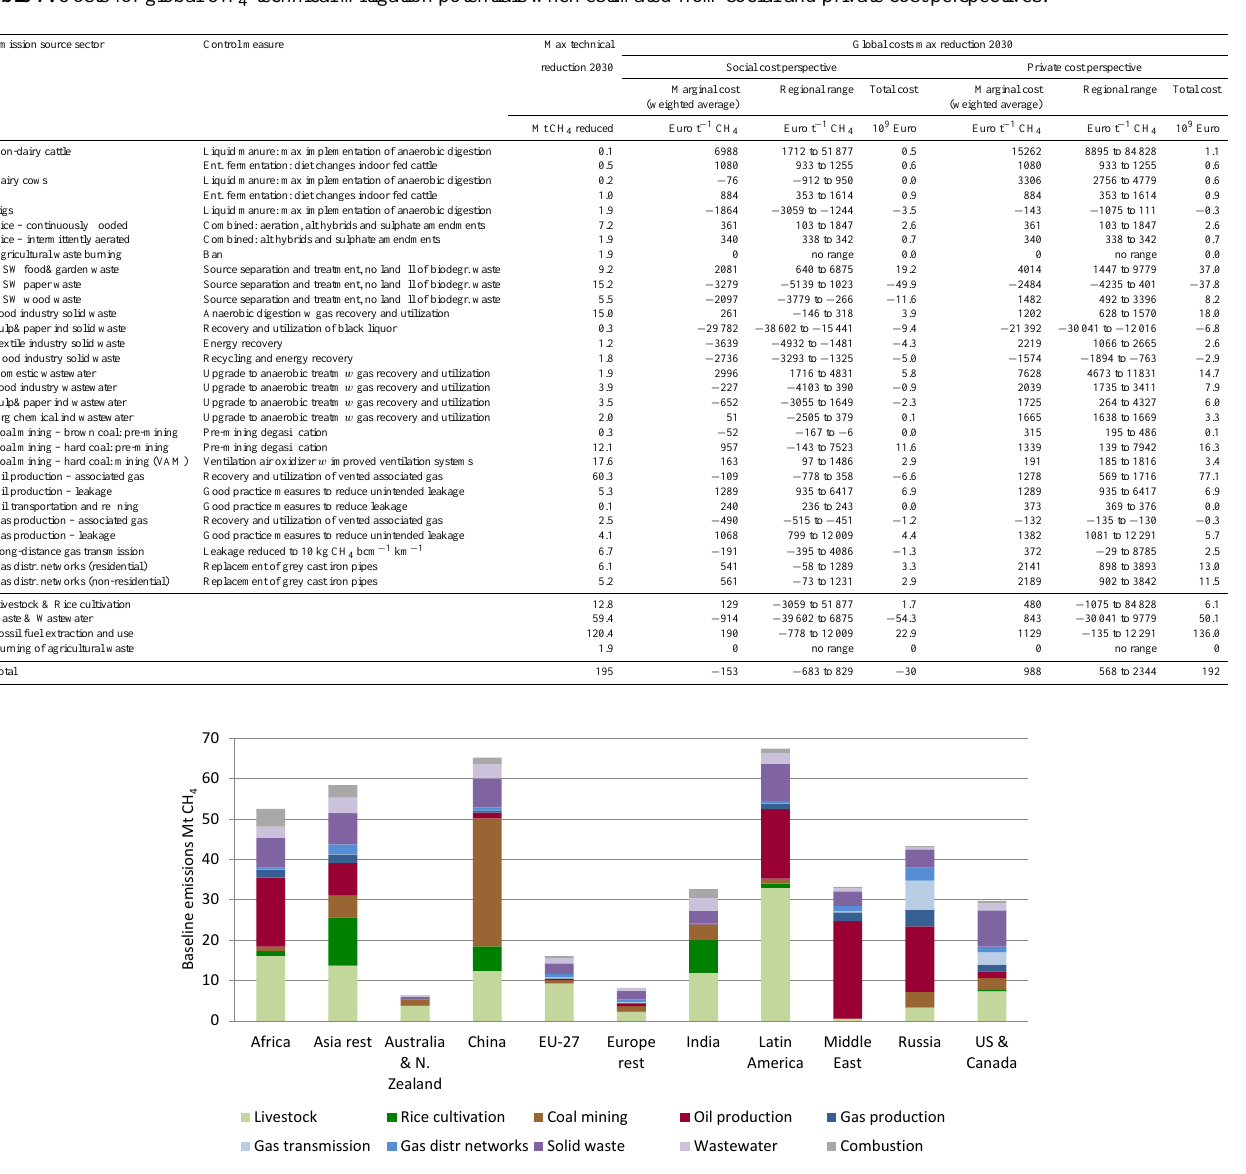
Fig. 4. CH 4 baseline emissions in 2030 by sector and world region.